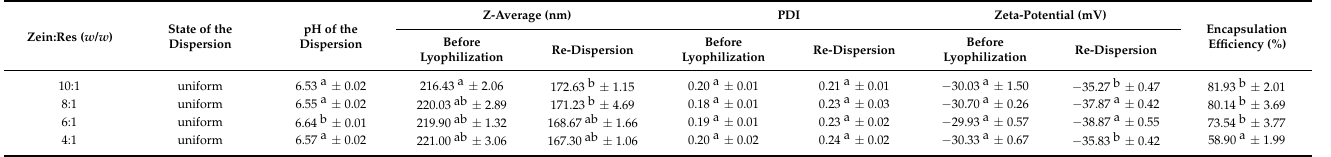
Table 1. Characterization of resveratrol-loaded zein-MSC nanoparticles *.